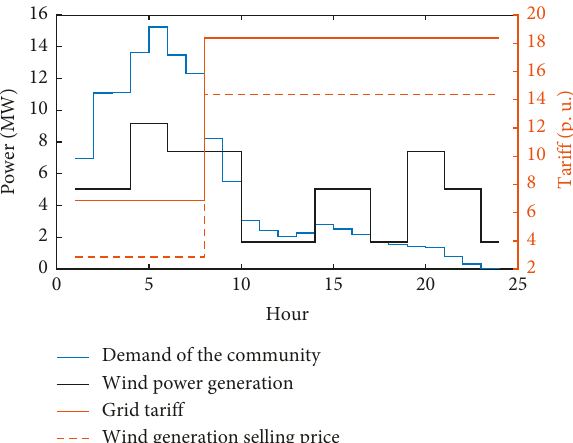
Figure 17: Demand of the community, wind power generation, grid tariff, and wind generation selling price at case study 1.